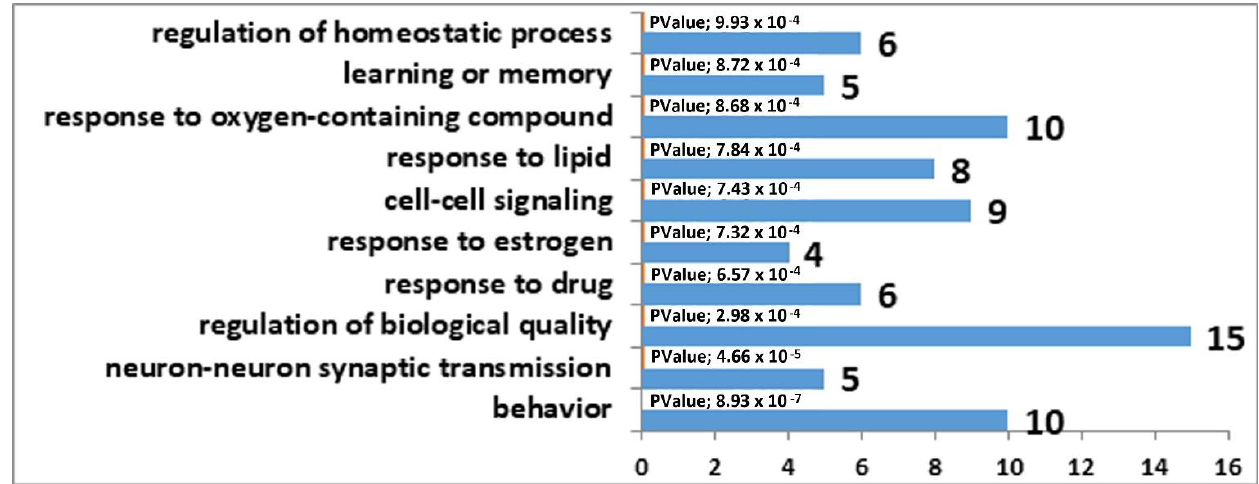
Figure 1. GO terms linked with the DEGs that correlated with Tph2 expression in the MRN transcriptome analysis of the winners. The horizontal axis represents the number of genes.